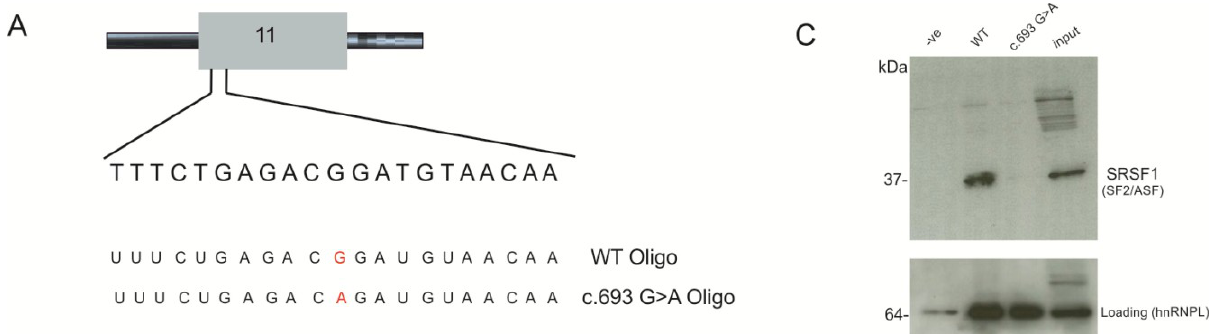
Figure 7A. The sequence CACACACA, able to bind hnRNPL [19], was added at the 3' end of both synthetic oligonucleotides, so that data could be normalised to hnRNPL binding. Proteins binding the synthetic RNAs were analysed by sodium dodecyl sulfate polyacrylamide gel electrophoresis (SDS-PAGE) followed by Coomassie blue staining (data not shown) and western blot. Figure 7. Pull down analysis of BRCA1 oligo WT and synonymous c.693G>A. ( A ) Schematic representation of the two oligonucleotides used for the pull-down assay. The WT oligo and the c.693G>A oligo carrying the variant (shown in red); ( B ) Western blot of the pull-down sample using hnRNP A1 antibody ( upper panel ) and hnRNPL ( lower panel ). hnRNPL represent the loading control. The −ve lane contain proteins purified from pull-down assays. The input lane contains 1/20 of input HeLa nuclear extract. The histograms show the % of intensity of the hnRNP A1 band calculated against the loading control using Image J. The percentages and standard deviation (error bars) are calculated from two biological replicates; ( C ) Western blot of the pull-down sample using SRSF1 antibody ( upper panel ) and hnRNPL ( lower panel ). The −ve lane contain proteins purified from pull-down assays. The input lane contains 1/20 of input HeLa nuclear extract; and ( D ) Western blot of the pull-down samples using the 1H4 antibody ( upper panel ). This antibody is able to detect several SR proteins (input lane), but only two bands corresponding to SRSF6 and SRSF9 are visible in the WT lane. hnRNPL represent the loading control ( lower panel ). The input lane contains 1/20 of input HeLa nuclear extract. The −ve lane represents the control sample from beads only, with no RNA. The WT and c.693G>A lanes contain proteins purified from pull-down assays. The histograms show the % of intensity of the SRSF6 and SRSF9 bands calculated against the loading (intensity of hnRNPL band) using Image J. The percentages and standard deviation (error bars) are calculated from two biological